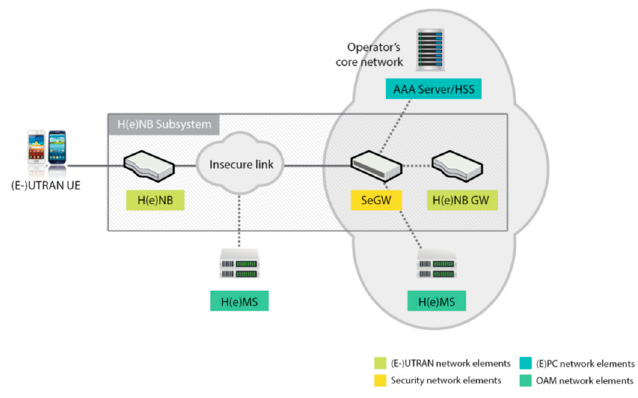
Figure 6. Connection diagram for the LTE Small Cell and Evolved Packet Core (EPC).